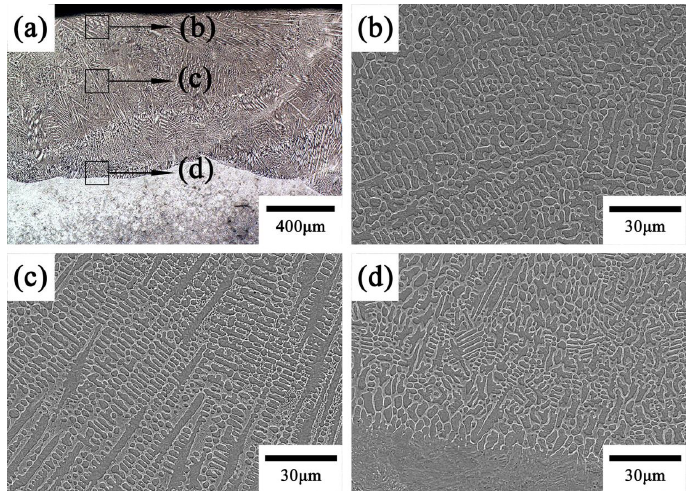
Figure 2. Typical structures of different regions of the laser cladding Co-based coating: ( a ) macrostructure of the cross-sectional morphology; ( b ) upper region; ( c ) middle region; ( d ) interface region.